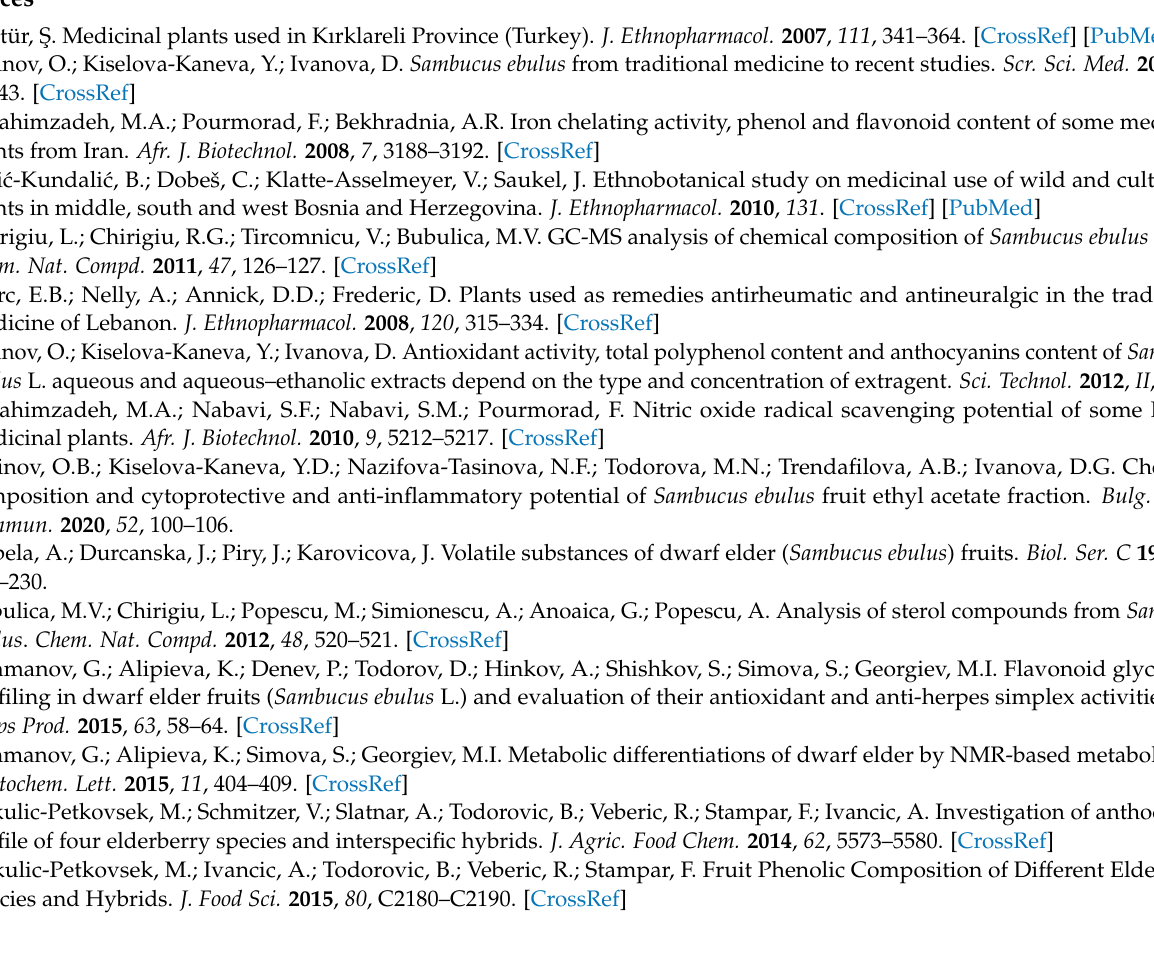
Table S1: Relative Kovat’s retention index (RI) of analyzed polar compounds (fraction A) presented in Table 1, using GC-MS technique, Table S2: Precursor ion and fragment ion mass-to-charge ratios (m/z) of the analyzed polyphenols using the LC-PDA-ESI-MS/MS